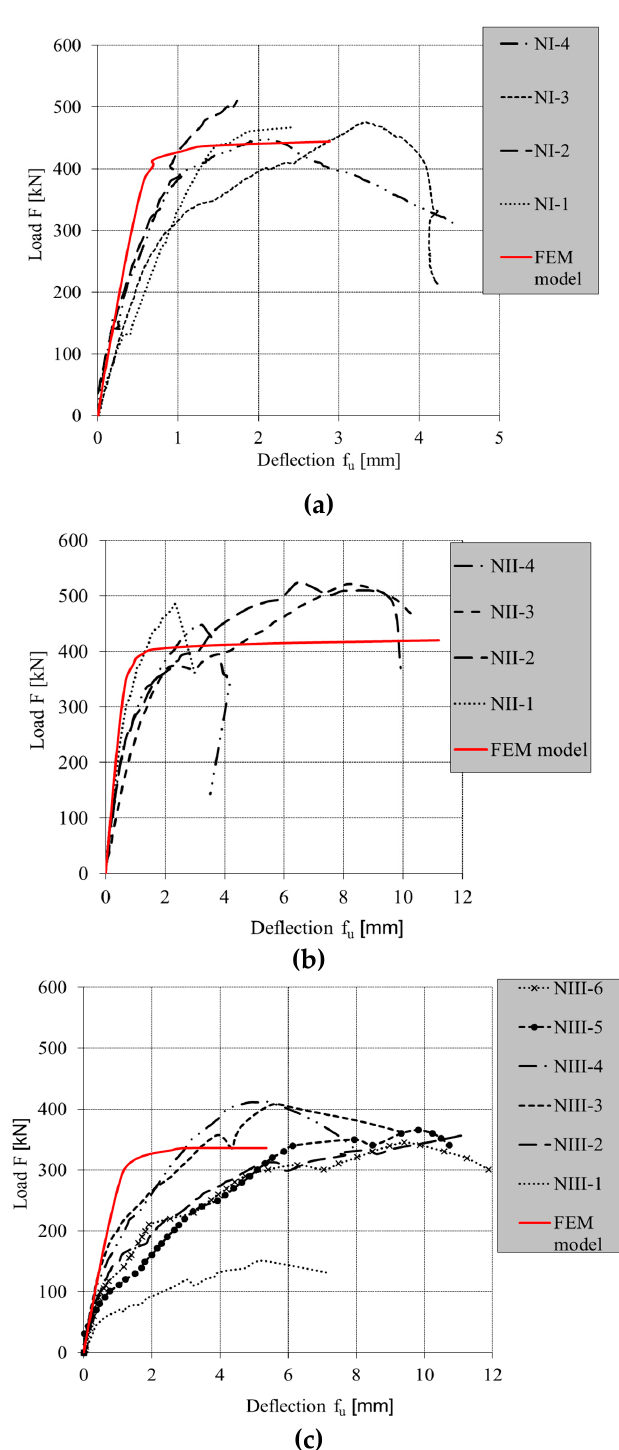
Figure 19. Compared relationship between the load and deflection of the lintel determined experimentally and from numerical calculations for the models of the following series: ( a ) NI, ( b ) NII, ( c ) NIII. ( b ) NII, ( c )